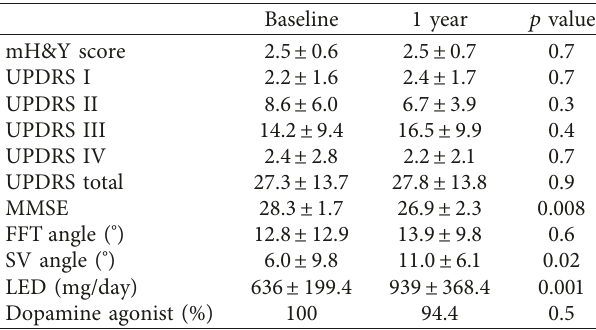
Table 4: Clinical assessment values upon enrollment (baseline) and after 1 year of